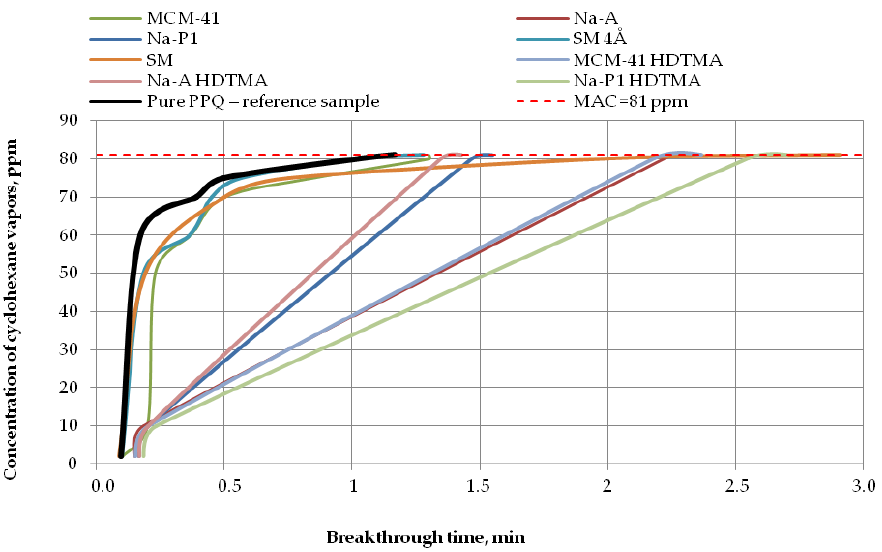
Figure 8. Breakthrough time for nonwoven zeolite and silica composites challenged with cyclohexane at MAC = 81 ppm.